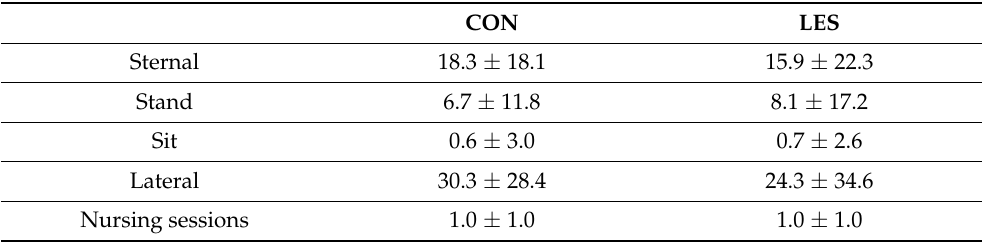
Table 3. Median duration (minutes) of each behavior plus or minus IQR for cases, those sows that developed a lesion (LES) and their matched control (CON) as well as the median number of nursing sessions. Sows were recorded on days 0, 7, and 14 post-lesion development for as long as they remained in farrowing. Each video was 1 h in duration.